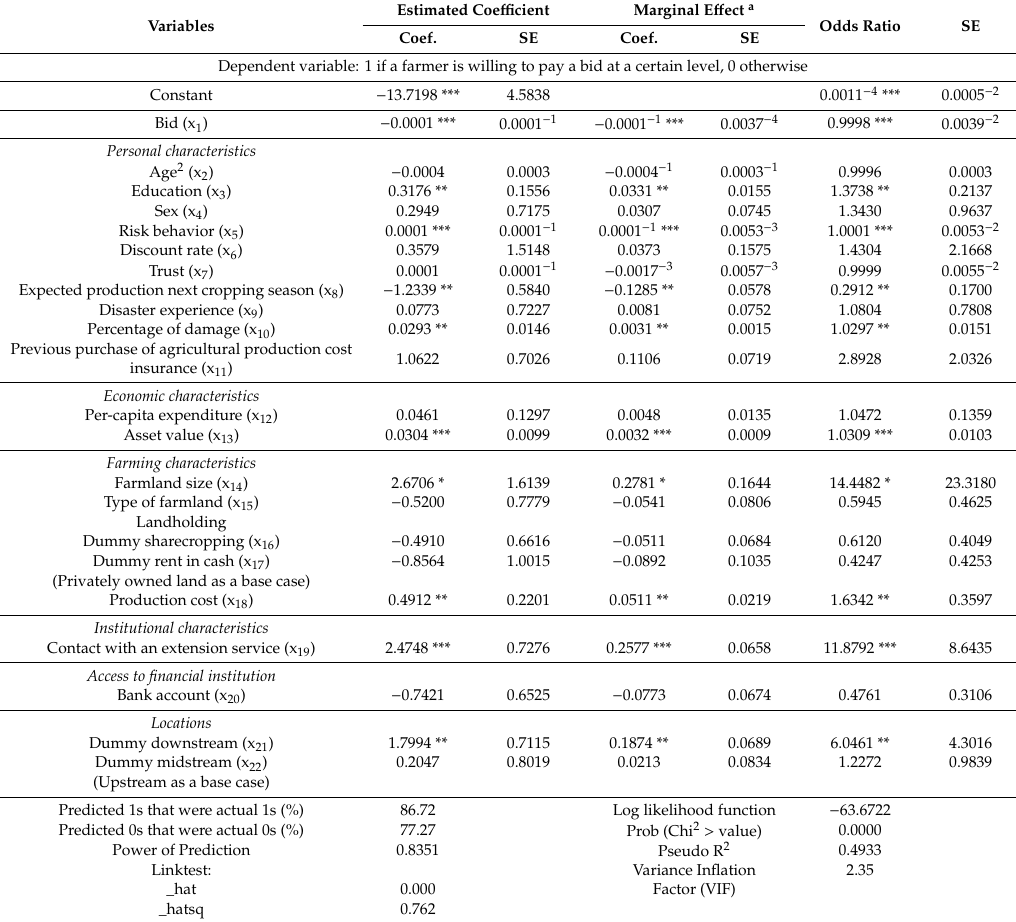
Table 6. Estimated coe ffi cients, marginal e ff ects, and odds ratios of the logit model.